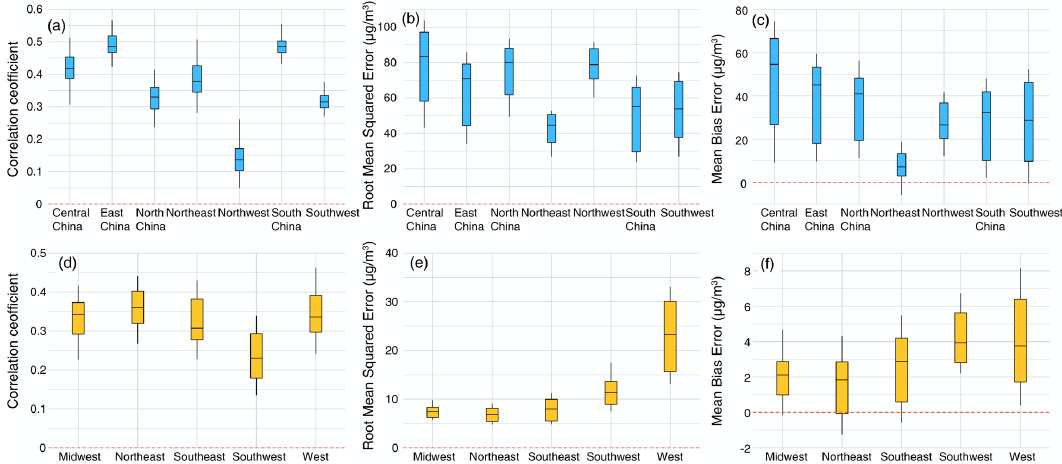
Figure 5. Boxplots of regional averaged correlation coe ffi cient, root mean squared error, and mean bias error at each forecasting time step in China ( a – c ) and United States ( d – f ). The black line in each box indicates the median value while the upper and bottom edges show data values at the 75% and 25% percentiles, respectively.